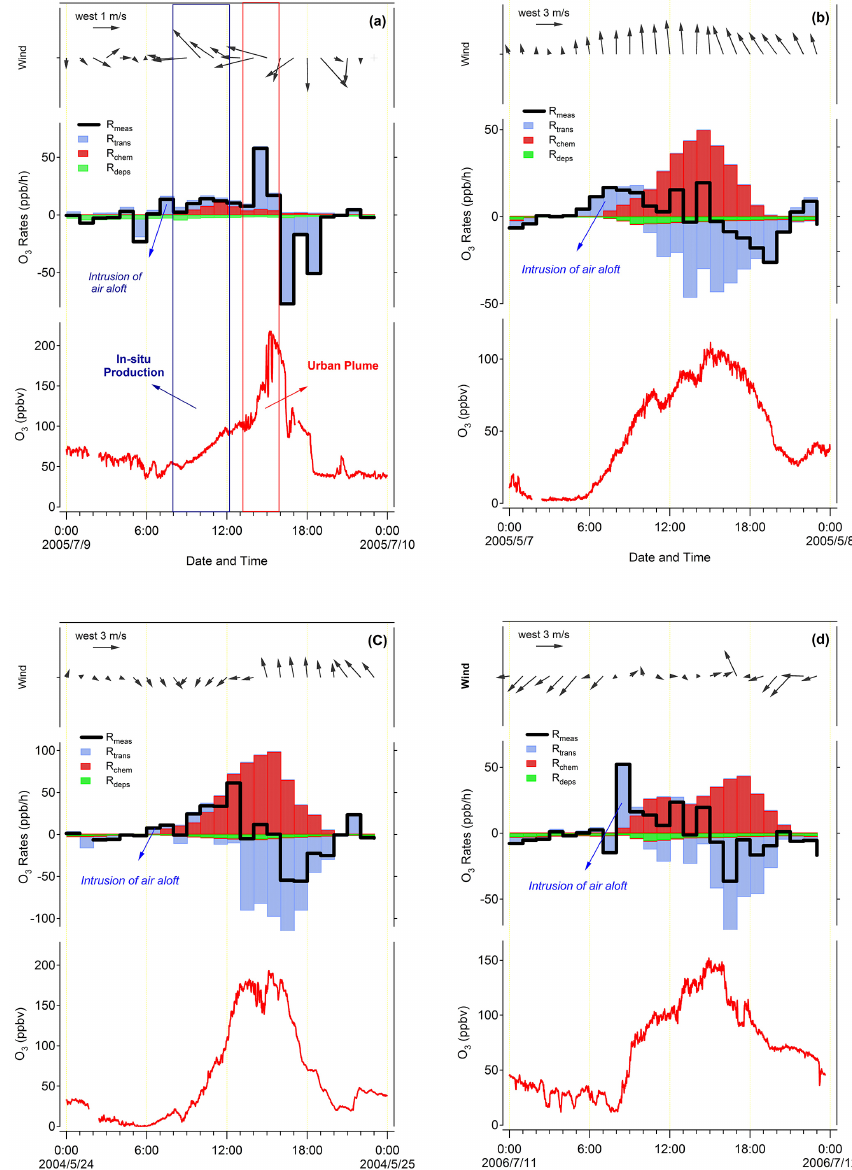
Figure 4. O 3 accumulation and contributions from in situ chemistry, regional transport, and deposition during episodes in (a) Bei- jing (9 July 2005), (b) Shanghai (7 May 2005), (c) Guangzhou (24 May 2004), and (d) Lanzhou (11 July 2006). Note that the blue bars are added to the red